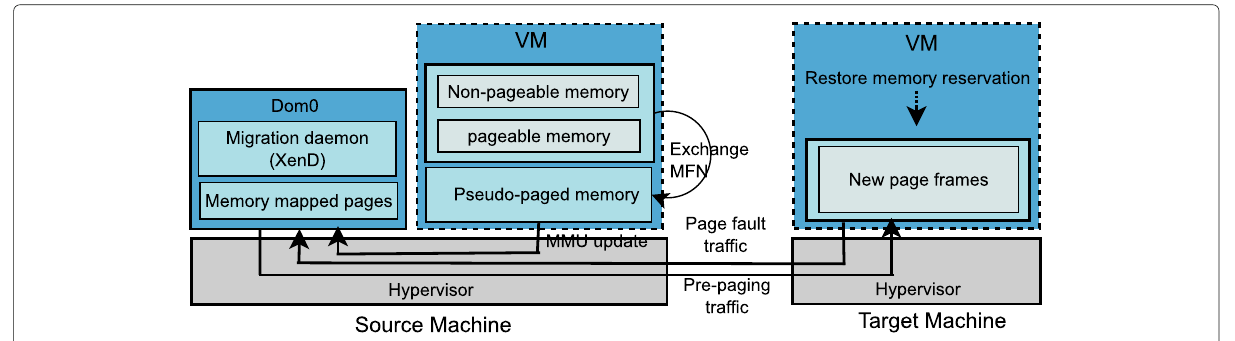
Fig. 9 Generic steps of context aware VM